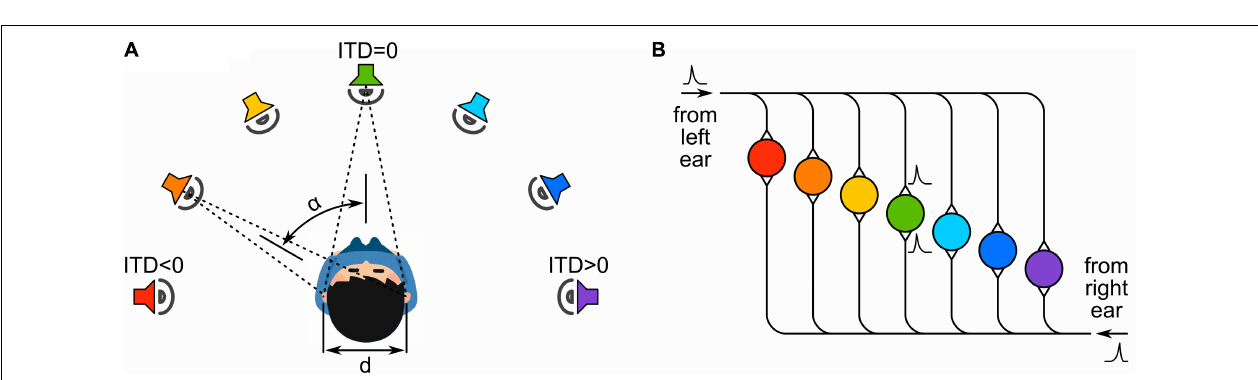
FIGURE 1 | (A) Electronic circuit of the UCN unit. The input (green) is shown for the case of two dendrites. In orange we depict the section of the circuit where the action potentials are generated (see text for description). (B) Schematic I-V characteristics of the SCR and electronic symbol of the component. Note the hysteretic behavior similar to that observed in VO 2 Mott neurons (del Valle et al., 2018). (C) Symbol of the artificial neuron for the case of a one-input (top) and two-input (bottom) UCN, which are used as lego -like building blocks (the list of the electronic components is provided in the Supplementary Material ).